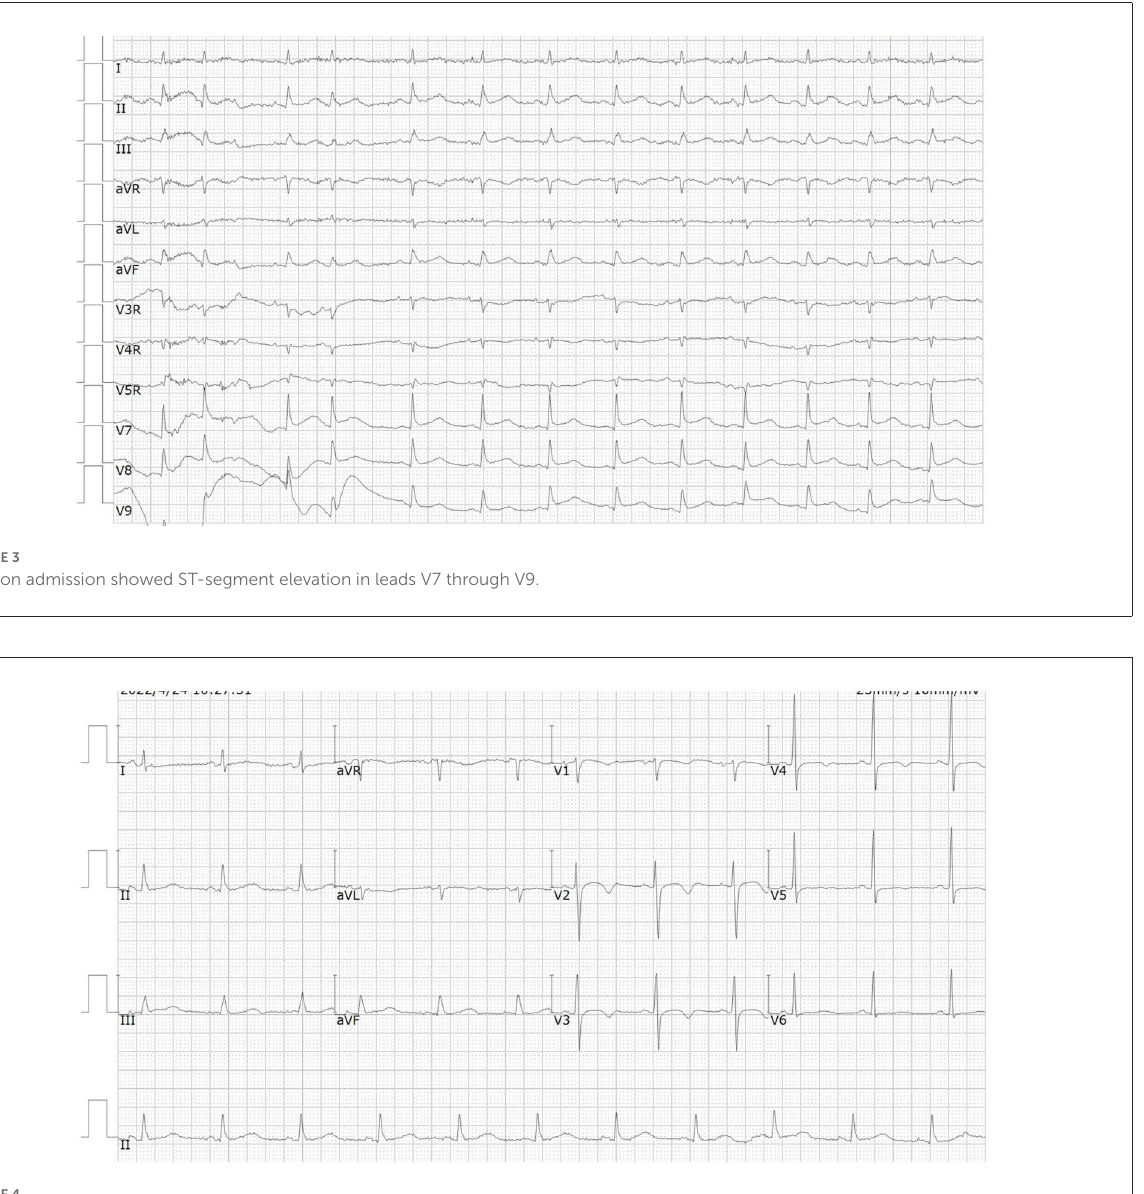
FIGURE4 ECG at day 4 showed the elevated ST-segment had fallen